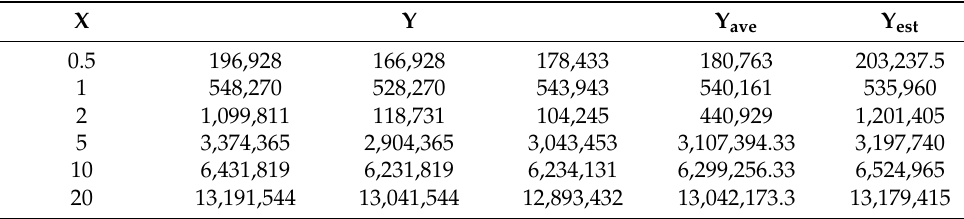
Table 1. Six concentration (X) levels and their peak areas (Y) in